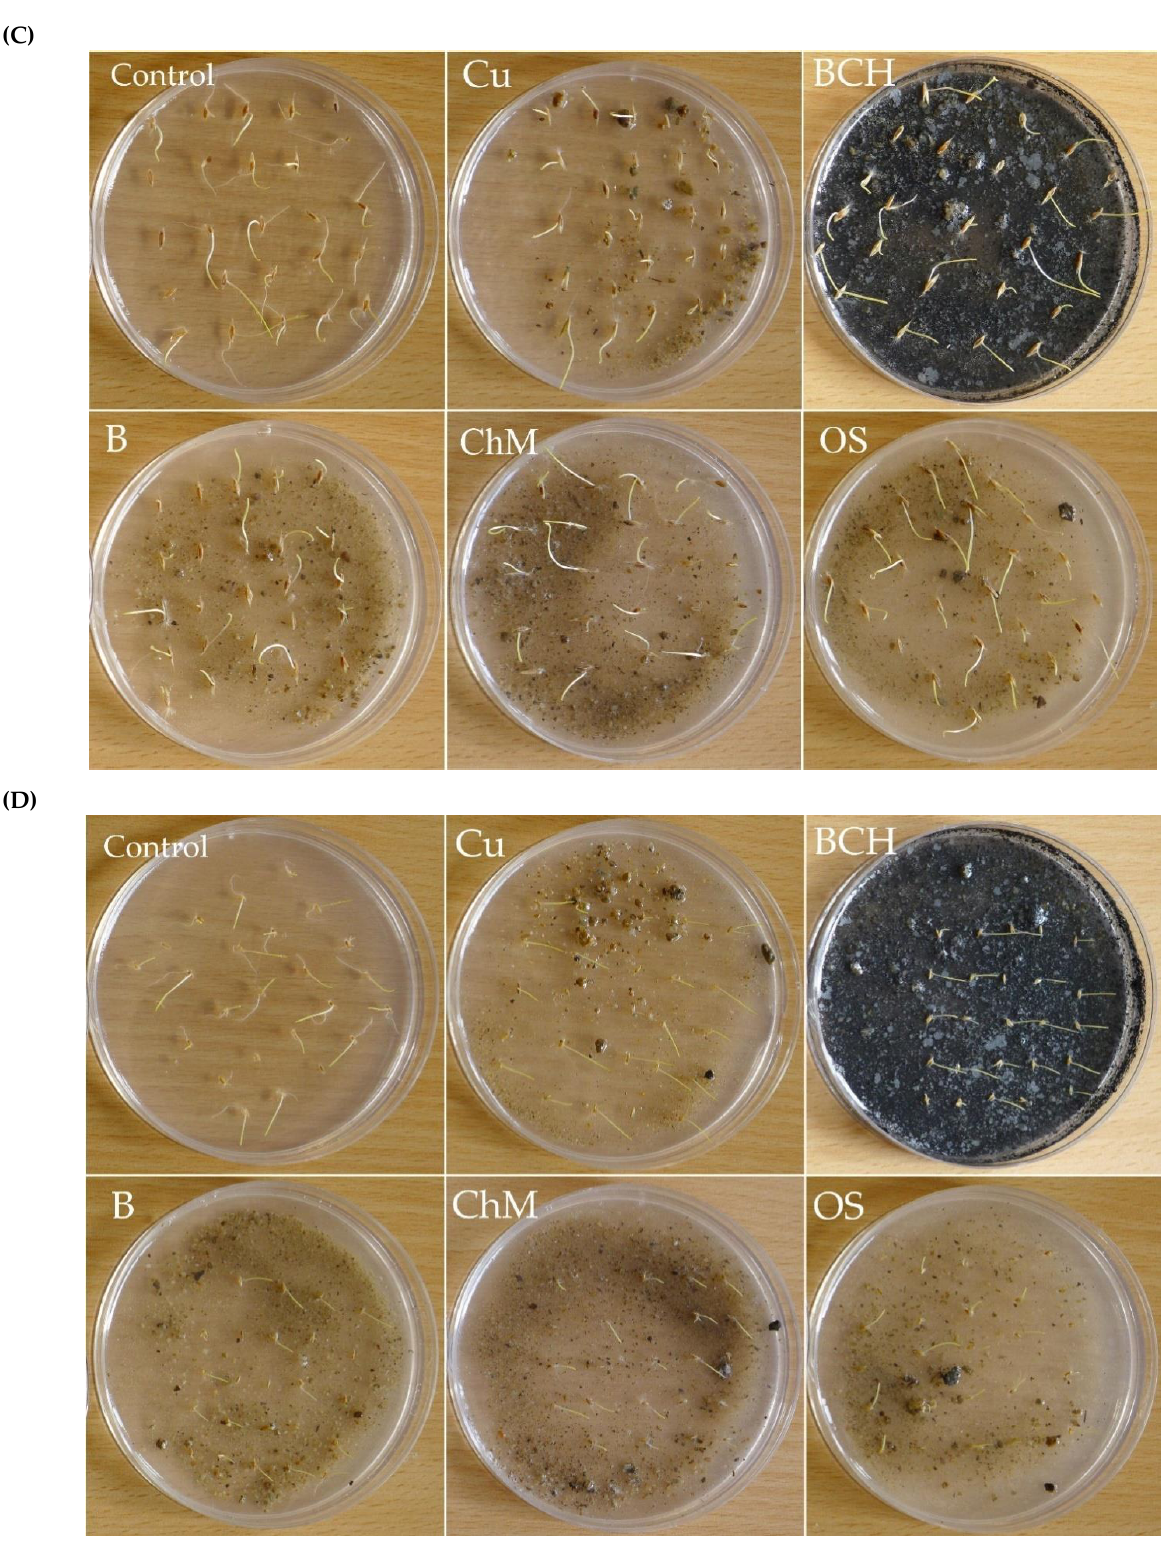
Figure 3. Petri dish tests after (sandwich method) 7 days of the experiment; ( A ) — Agrostis capillaris L., ( B ) — A. stolonifera L., ( C ) — Festuca rubra L., ( D ) — Poa pratensis L.; Control — distilled water, Cu — copper soil; copper soil with sorbents: BCH —